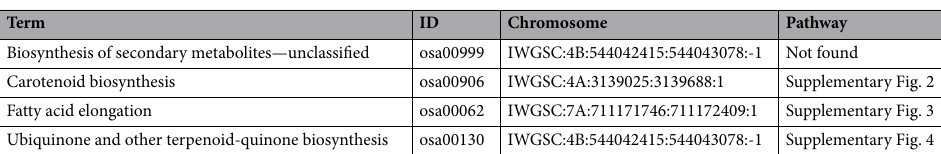
Table 5. KEGG orthology-based annotation system for significant SNP sequences.